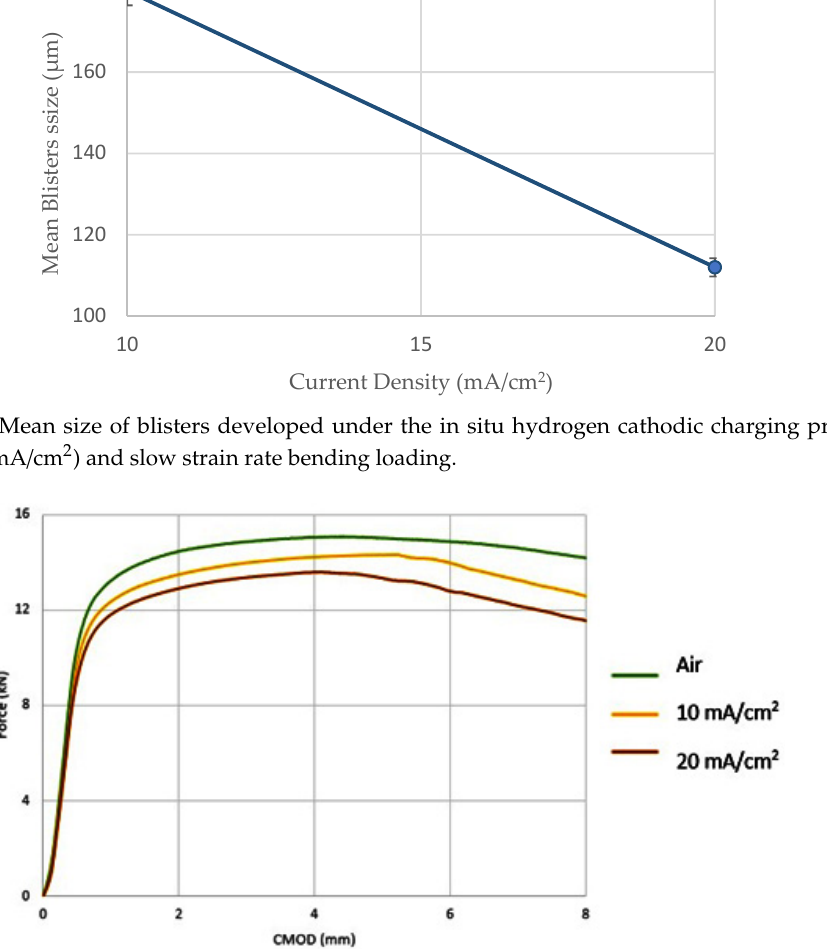
Figure 14. Mean size of blisters developed under the in situ hydrogen cathodic charging process (10 and 20 mA/cm 2 ) and slow strain rate bending loading.